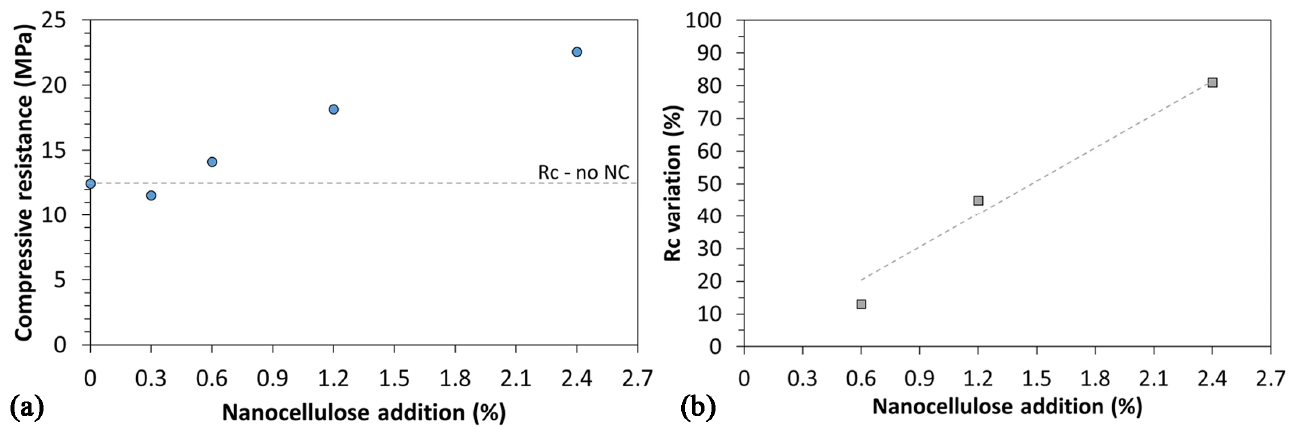
Figure 9. ( a ) Compressive resistance Rc of mortars as a function of ONC content; ( b ) Rc variation of mortars as a function of ONC content.